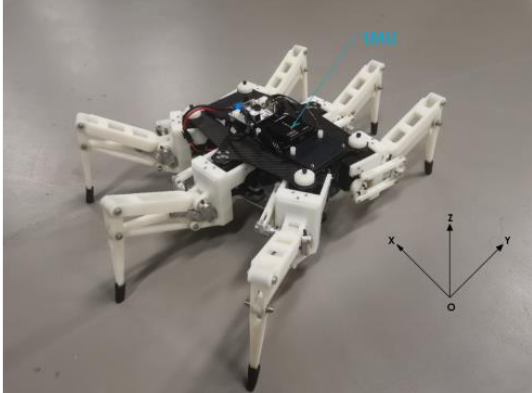
Figure 16. Robot experiment scene.